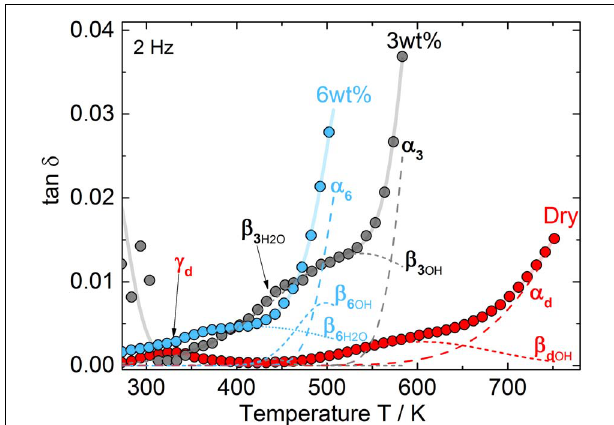
FIGURE 3 | Mechanical loss spectra in dry and water-bearing microscope slide glass samples for f = 2 Hz. Red circles: nominal dry glass (0W-MSG0), gray circles: 3 wt% water (3W-MSG500), blue circles: 6 wt% water (6W-MSG500). Dashed curves: deconvoluted Gaussian fits for γ -, β H 2 O -, β OH -, and α -relaxation.